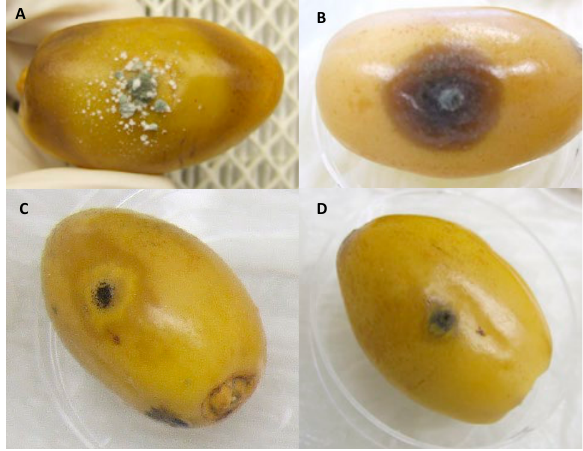
Figure 5 . Symptoms of postharvest disease on ‘Medjool’ dates artificially inoculated with Penicillium expan sum (A), Alternaria alternata (B), Aspergillus niger (clade) (C) or Clado- sporium cladosporioides (D) and incubated at 20ºC for 10